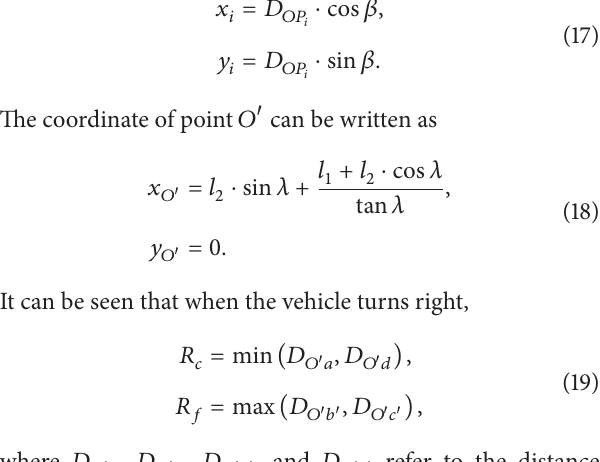
Figure 5: Obstacles along the vehicle’s